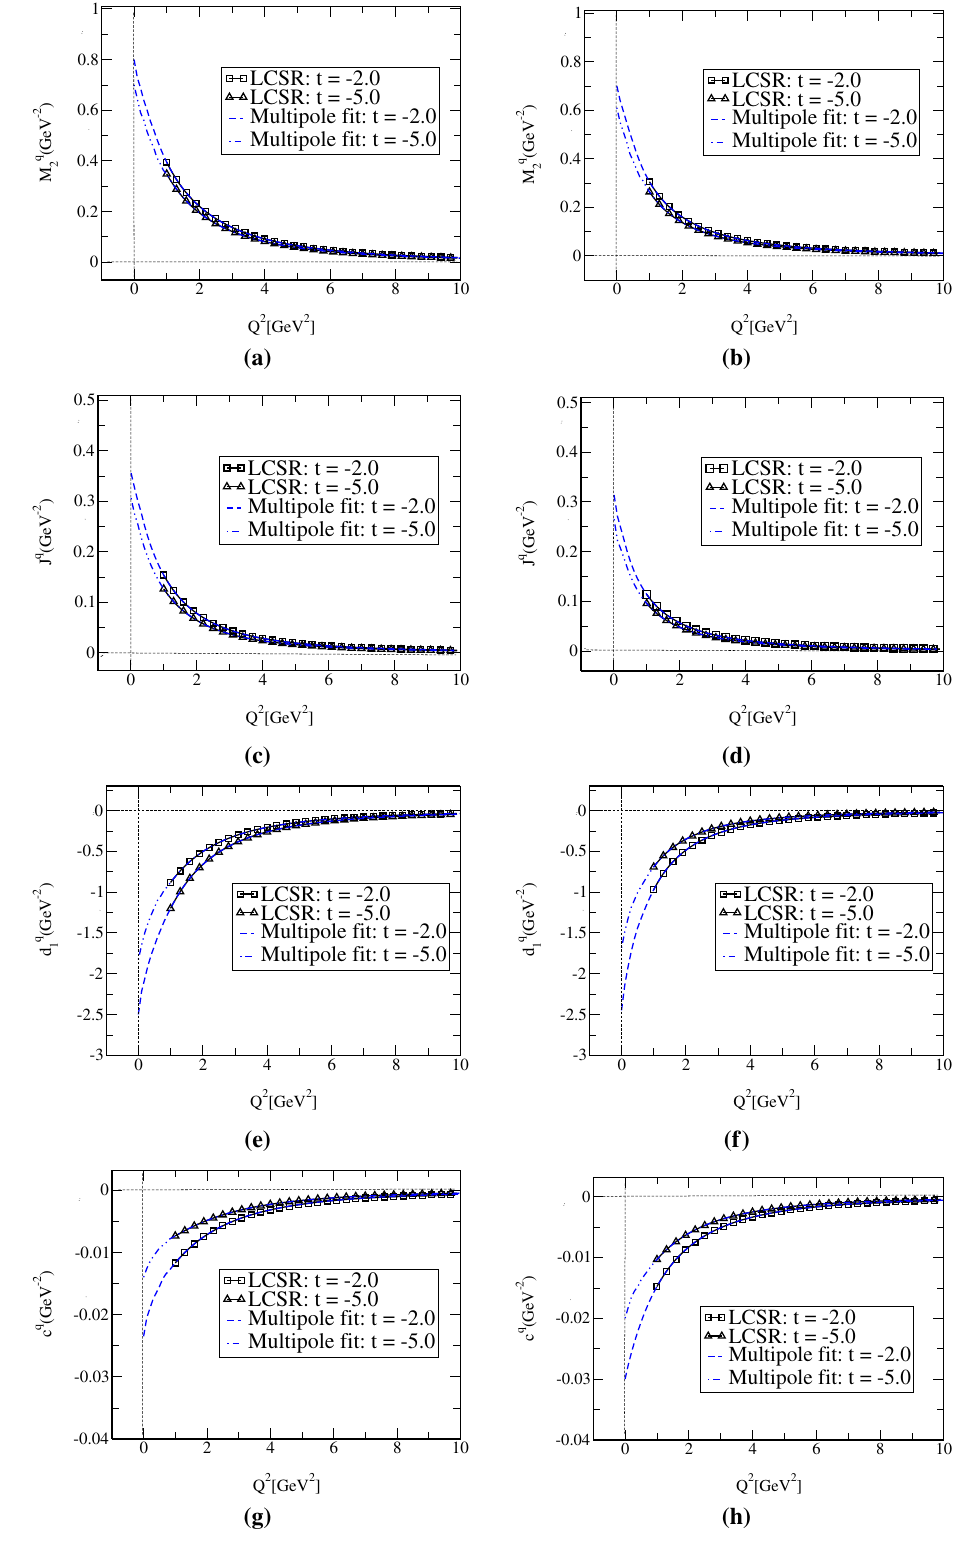
Fig. 2 The dependence of the EMTFFs of nucleon on Q 2 at M 2 = 1.5 GeV 2 , s 0 = 2.25 GeV 2 and different values of t : a , c , e and g for the first set of DAs; b , d , f and h for the the second set of DAs. The dashed and dot-dashed curves show the results of the fit functions of the multipole